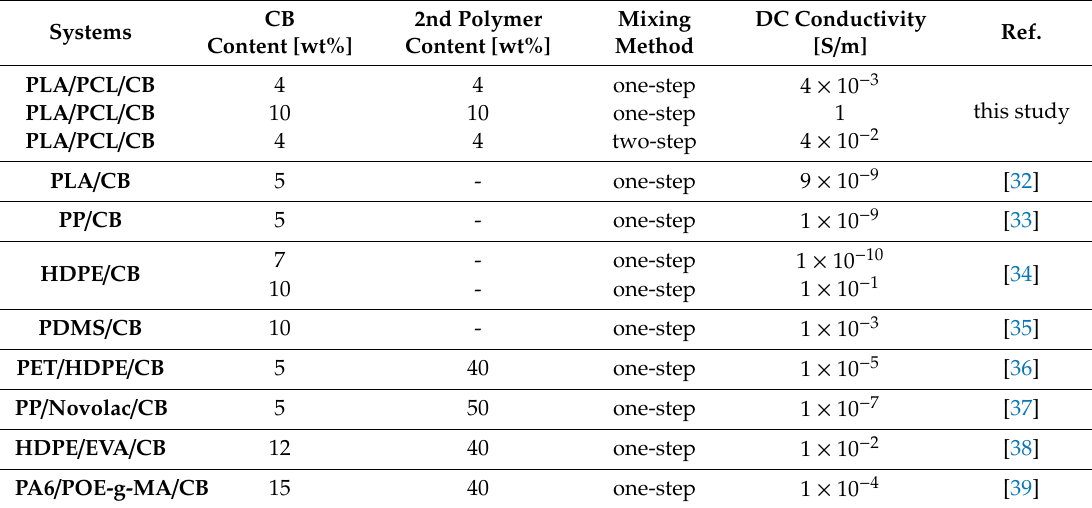
Table 5. Comparison of DC electrical conductivity of various composites containing the CB particle used in this study.